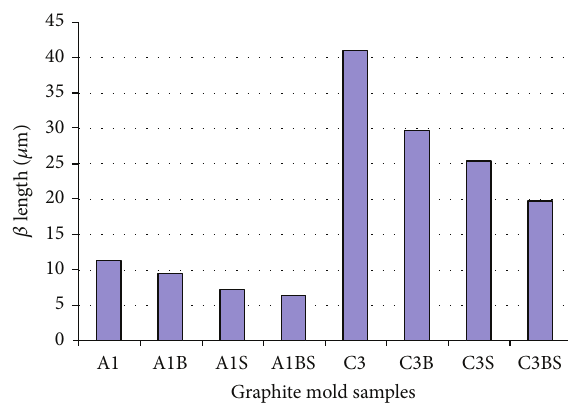
Figure 9: Histogram exhibiting the variation in 𝛽 -Al 5 FeSi phase average length affected by the composition of the